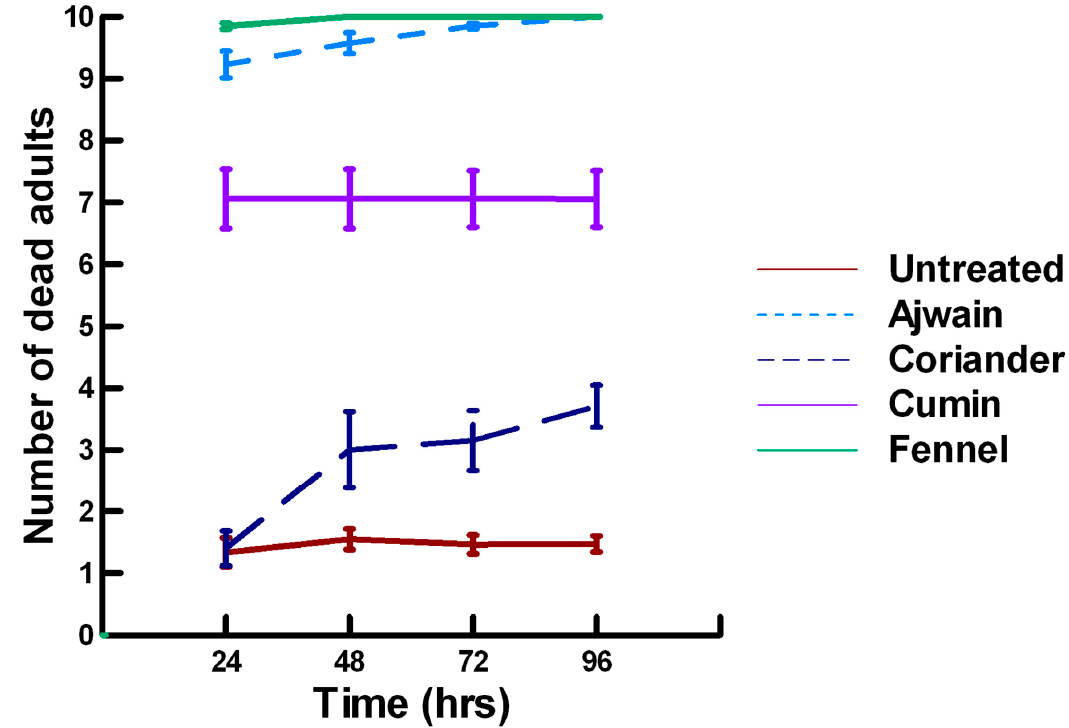
Figure 2. Acute contact toxicity with a low concentration of plant powders from the family Apiaceae (Ajwain, coriander, cumin and fennel) adherent to adult Pteromalus venustus . Means and standard error shown.